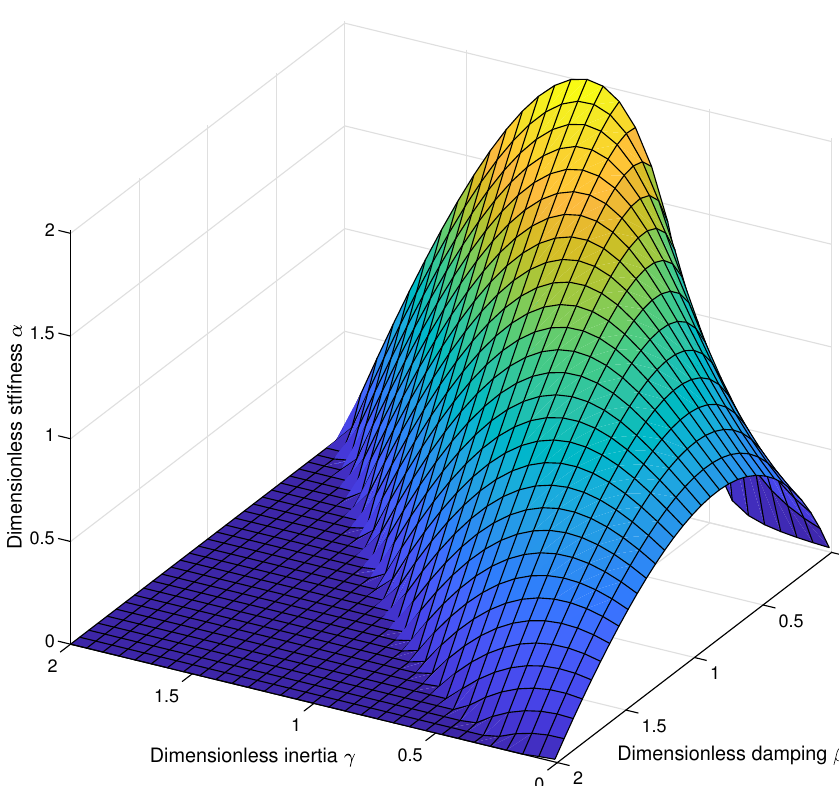
Figure 6. Stability boundaries for virtual spring-mass-damper